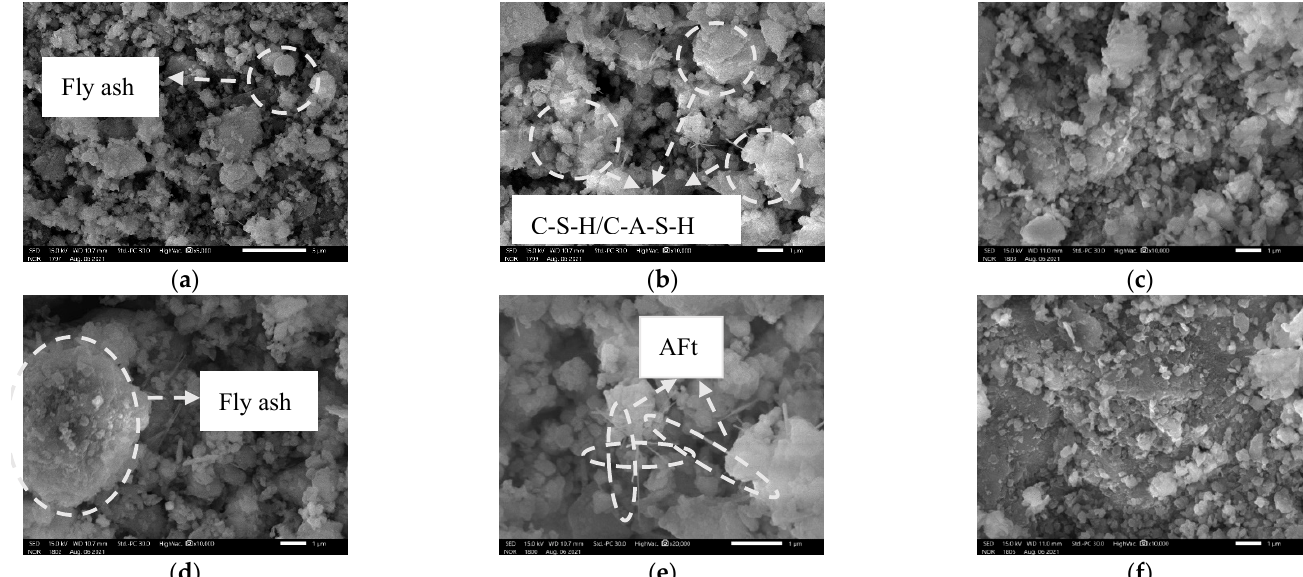
Figure 11. Microstructure after 28 d of curing: ( a )×5k; ( b )×10k; ( d )×10k; ( e )×20k. Microstructure after 10 w-d cycles: ( c ) FCCR1×10k; and ( f ) FCCR5×10k.